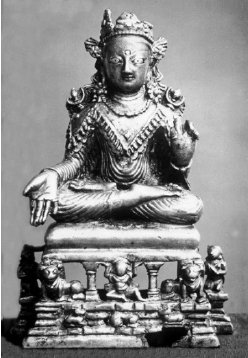
Figure 18. Buddha wearing a crown and cape with crescent moon and sun symbols. Approx. 675–722 C.E. Kashmir or Gilgit. Brass. 7 ¼” H. Pan-Asian Collection https://www.himalayanart.org/items/61436. Copyright@ 2018 Himalayan Art Resources Inc.